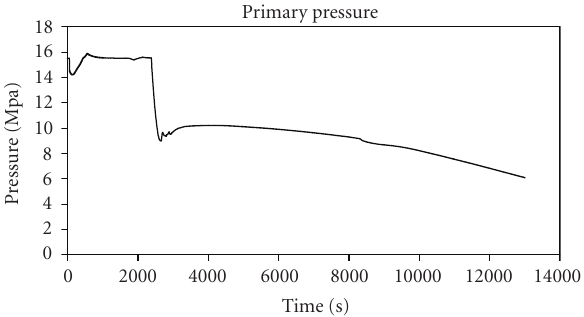
Figure 11: Primary pressure (F&B base case).